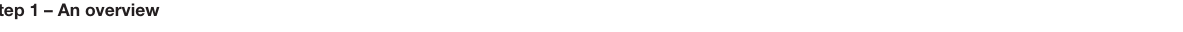
TABLE 3 | Example of analysis